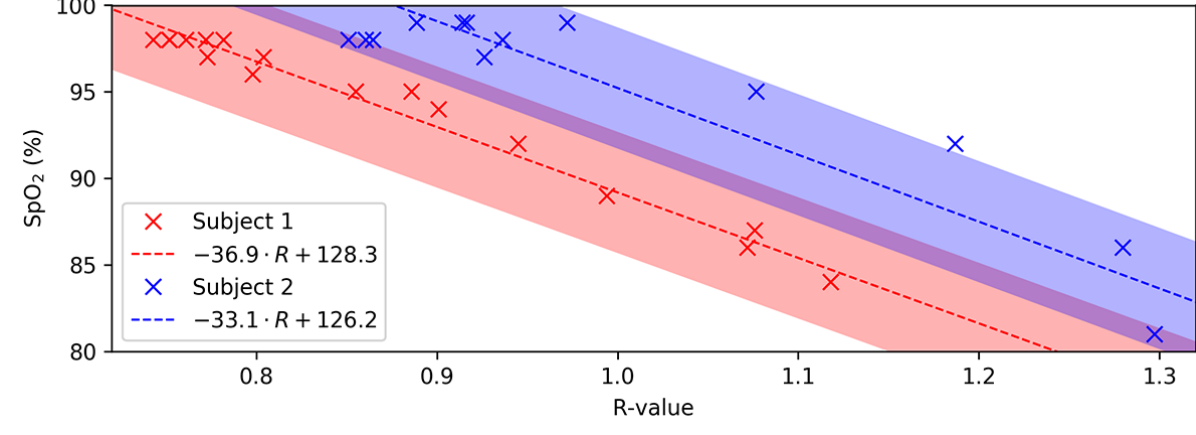
Figure 5. When characterizing the R-value for SpO 2 (peripheral oxygen saturation) estimation on the seat with controlled desaturation testing, the R-curve slope matches literature and is the same across subjects. A different offset necessitates the use of a per-subject calibration for absolute SpO 2 estimation. The shaded regions represent the acceptable level of error around the best fit line according to the ISO standard for pulse